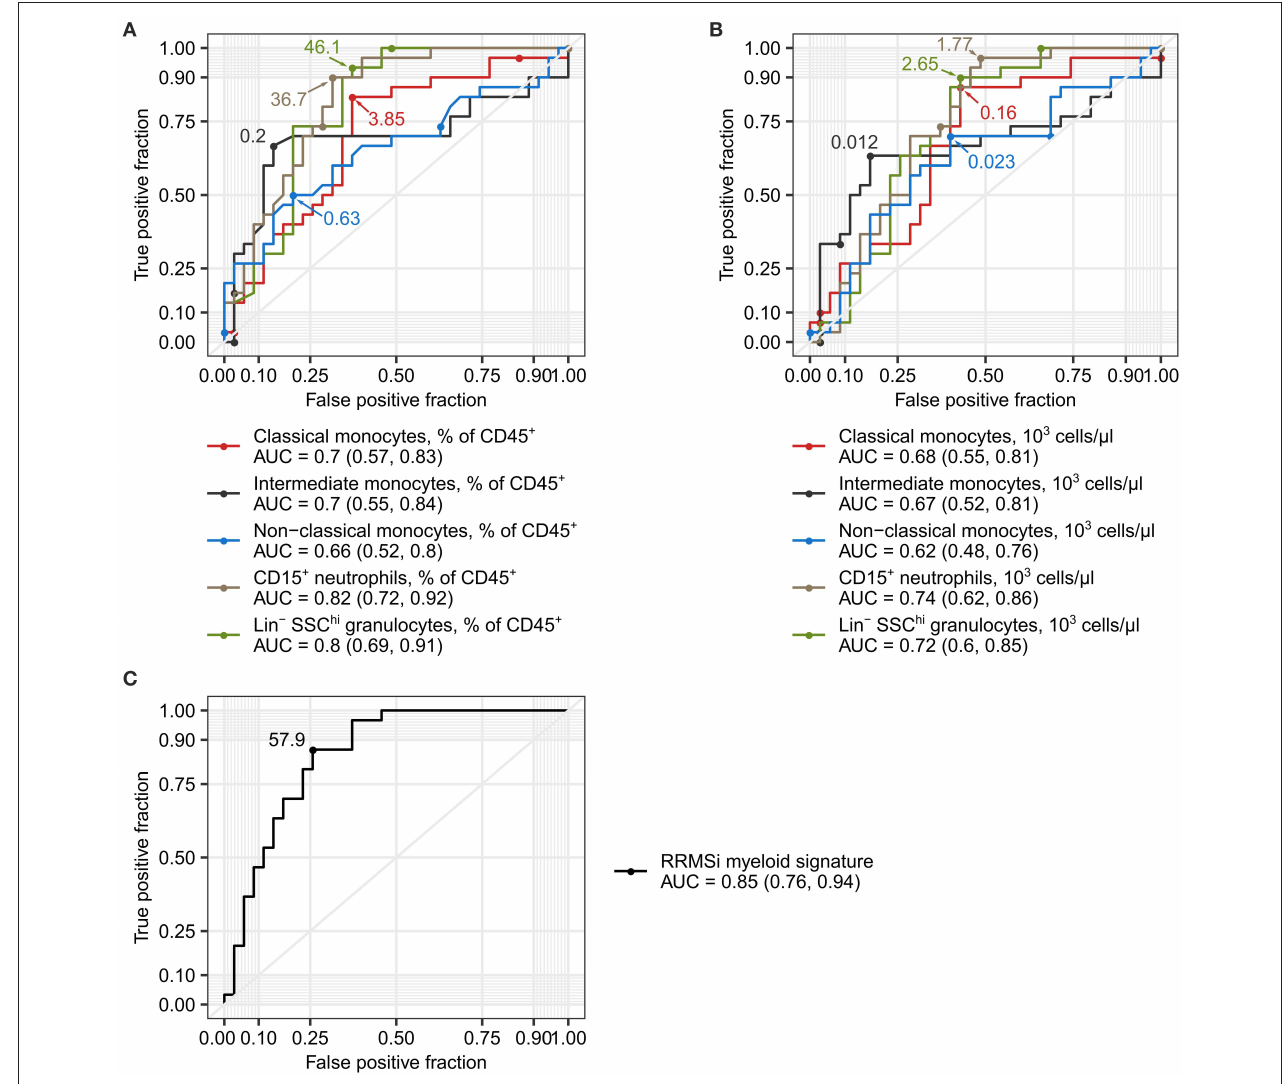
FIGURE 6 | Levels of neutrophils and classical and nonclassical monocytes as inactive relapsing-remitting multiple sclerosis (RRMSi) markers. Lin + lymphocytes, Lin − SSC hi granulocytes, CD15 + neutrophils, and monocyte subpopulations were identified and quantified in MS study participants stratified by disease course type [active progressive MS (PMSa): n = 14, inactive progressive MS (PMSi): n = 13, active relapsing-remitting MS (RRMSa): n = 8, and inactive relapsing-remitting MS (RRMSi): n = 30] as presented in Supplementary Figure S1 . Myeloid signature was calculated as an optimally weighted sum of percentages of neutrophils and classical